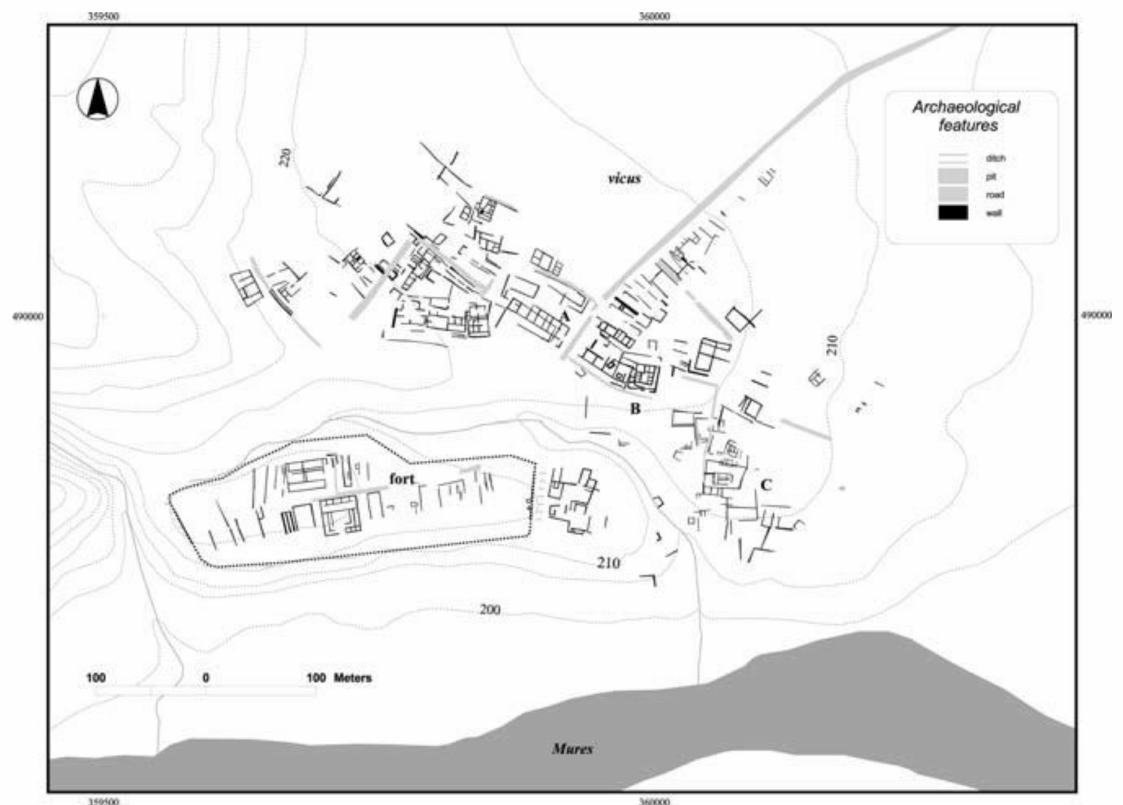
Figure 7. Germisara archaeological site – drawing of the main archaeological features ( © [43]).